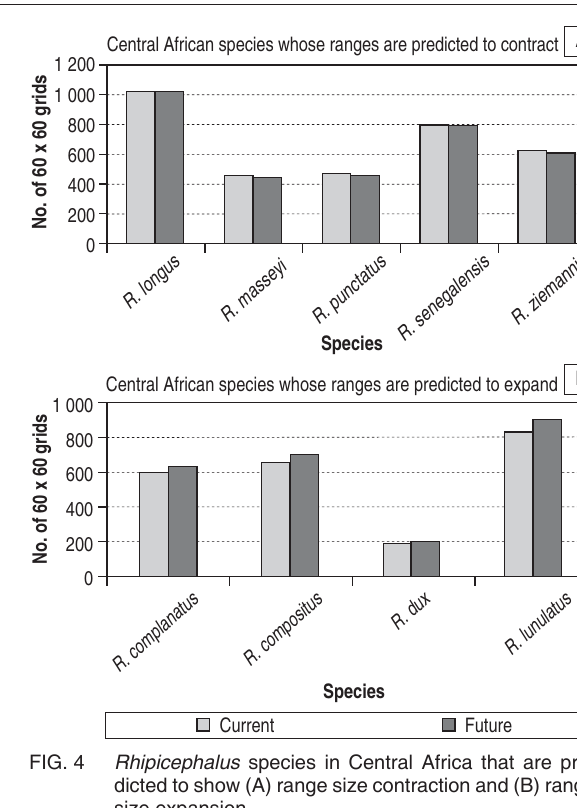
Fifty-five percent of species in central Africa are pre- dicted to show range reductions ( R. longus, R. mas- seyi, R. punctatus, R. senegalensis and R. zie manni ) while 45 % ( R. complanatus , R. compositus , R. dux and R. lunulatus ) are predicted to show range ex- pansions. Although the ranges of the majority of tick species are predicted to contract, the total area of contraction is only 19 %, while the total area of expan- sion by the remaining species is 81 %. The tick spe- cies predicted to expand its range most in this region is R. lunulatus with a total expansion of 252 000 km 2 .